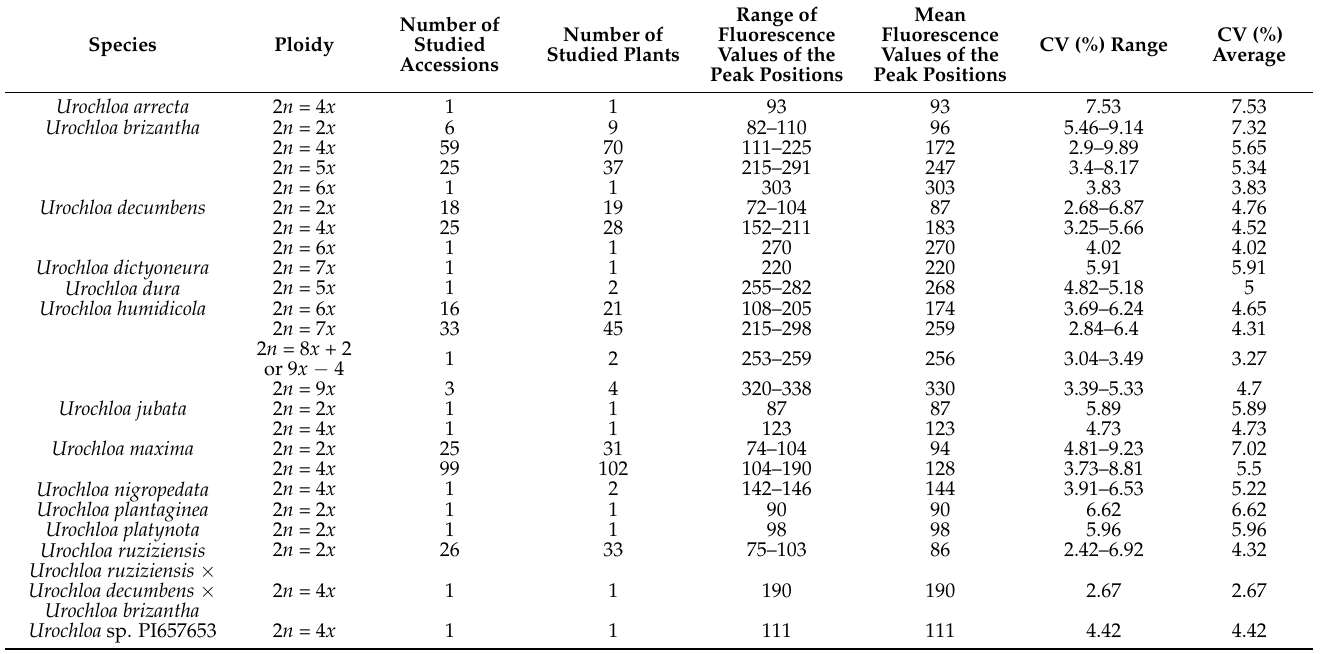
Mean Range of Number of Fluorescence Number of Fluorescence Studied CV (%) Range CV (%) Average Values of the Studied Plants Values of the Accessions Peak Positions Peak Positions